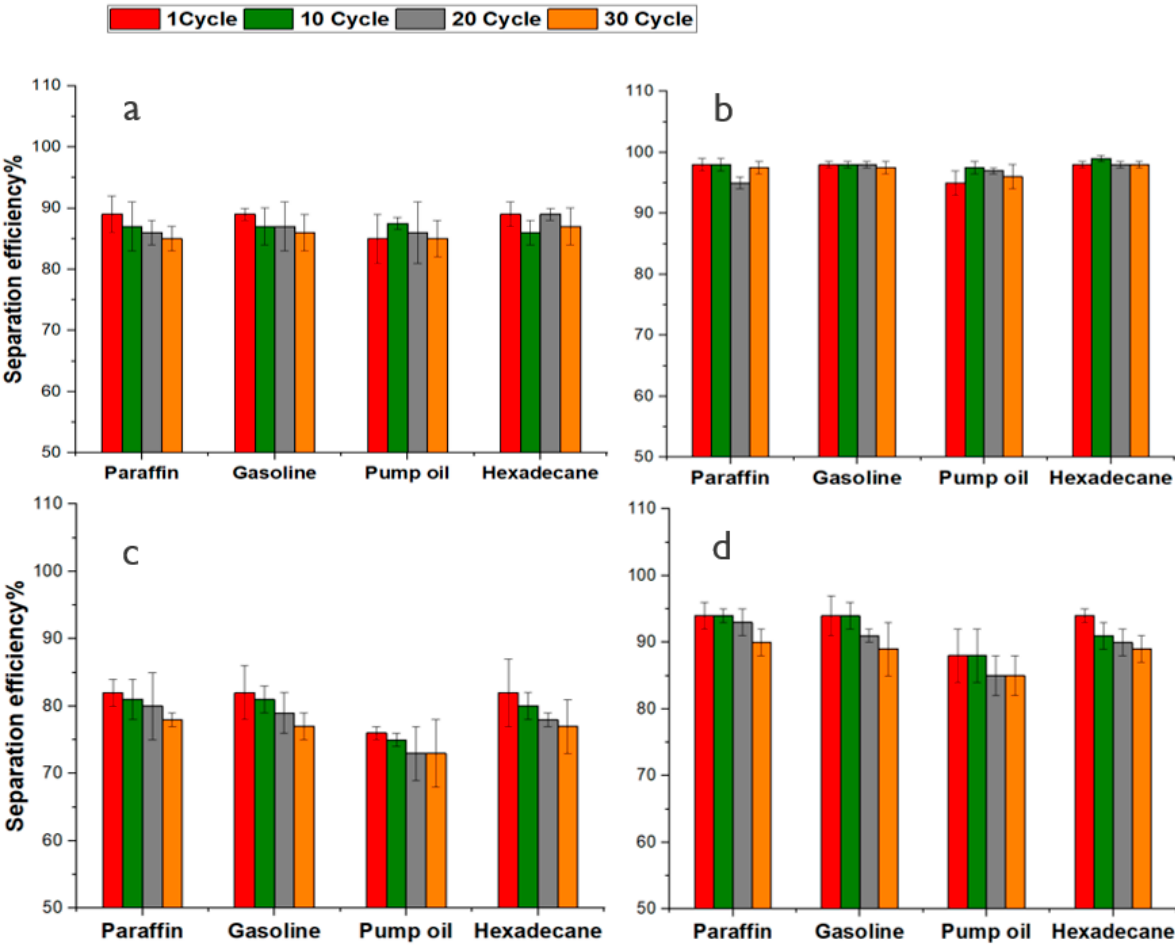
Figure 7. The separation efficiency of ( a ) Si-Cot_Dip ( b ) Si-Cot_Dip/O 2 ( c ) Si-Cot_Plasma ( d ) Si- Cot_Plasma/O 2 at room temperature for oil/water mixtures.